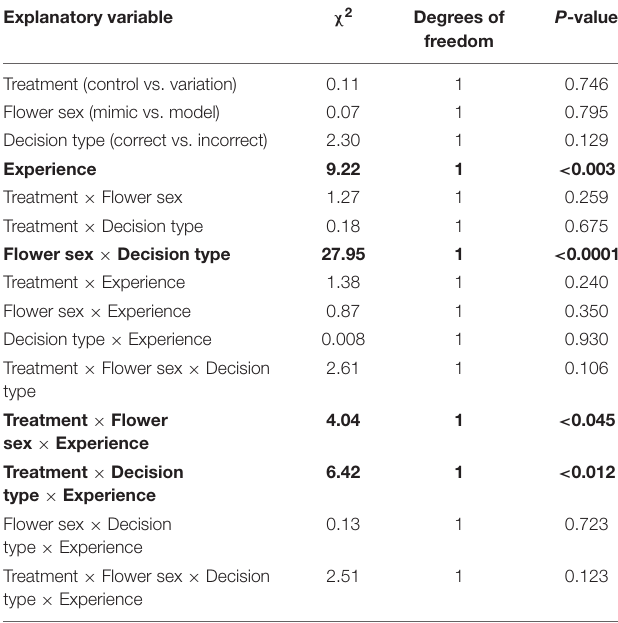
TABLE 1 | Type II Wald Chi-square tests for log(response time) as the response